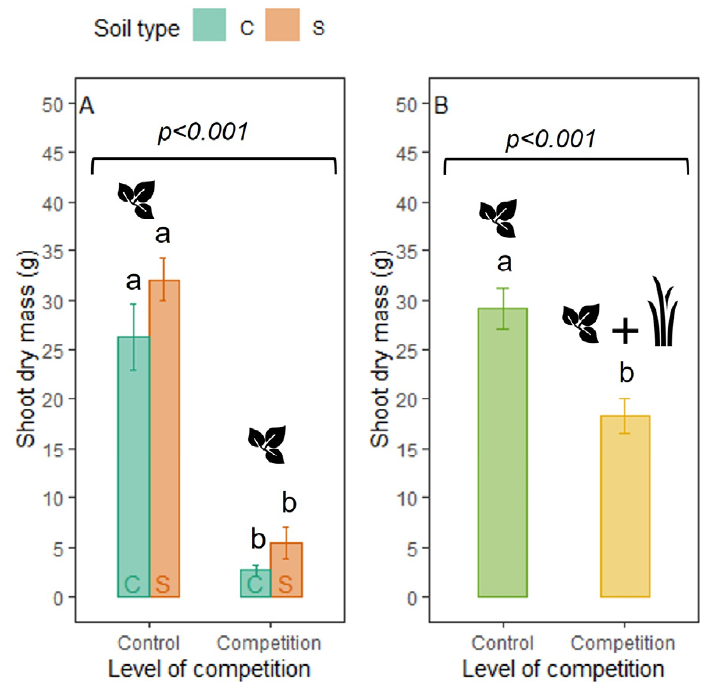
Figure 3. ( A ): Mean shoot dry mass of LANZA ® by soil type and level of competition. ( B ): Mean shoot dry mass averaged by soil type of LANZA ® grown without competition (control) compared to total shoot dry mass in competition treatment ( L. multiflorum plus LANZA ® ). The p values indicate the main effect of competition; the main effect of soil was not significant. Mean values ( n = 6) not sharing a common letter differ significantly ( p < 0.05) according to Tukey’s test. Error bars